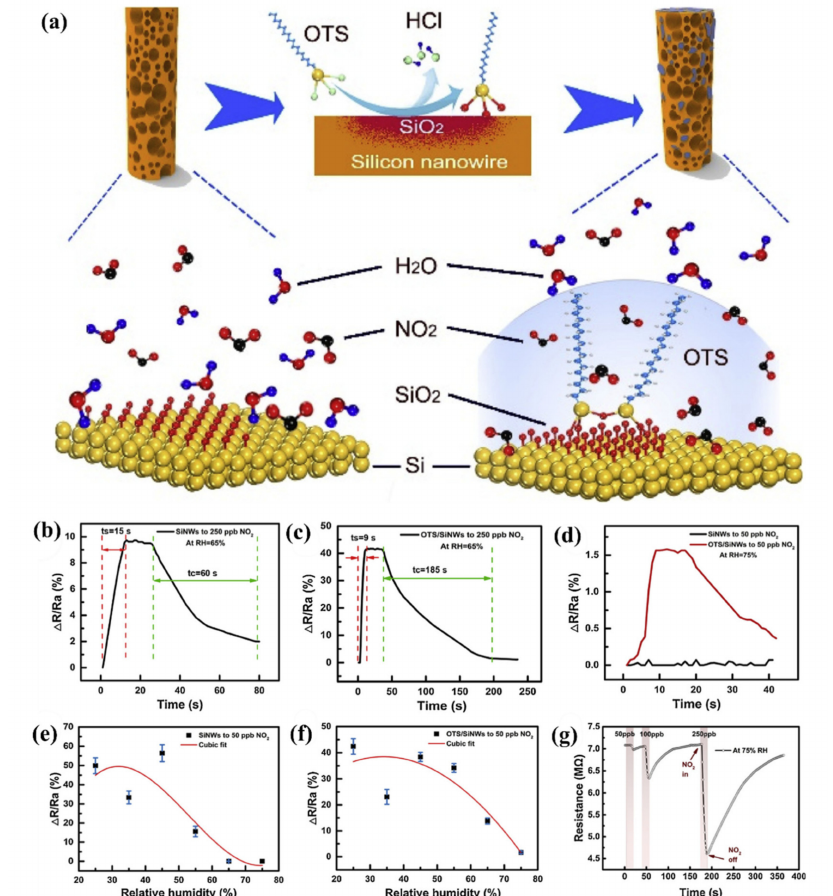
Figure 29. ( a ) Schematic illustration of construction of OTS-modified porous SiNWs for NO 2 detection under high humidity condition, ( b ) Dynamic responses to 250 ppb NO 2 at 65% RH for SiNWs sensor and ( c ) OTS / SiNWs sensor, ( d ) dynamic responses of OTS / SiNWs and SiNWs sensors to 50 ppb NO 2 at 75% RH. ( e ) response value versus relative humidity and corresponding cubic fits (red line) for SiNWs sensor, ( f ) OTS / SiNWs sensor towards 50 ppb NO 2 , and ( g ) dynamic response of OTS / SiNWs sensor to varying concentration of NO 2 at 75% RH. Reproduced from [116], with permission from Elsevier,